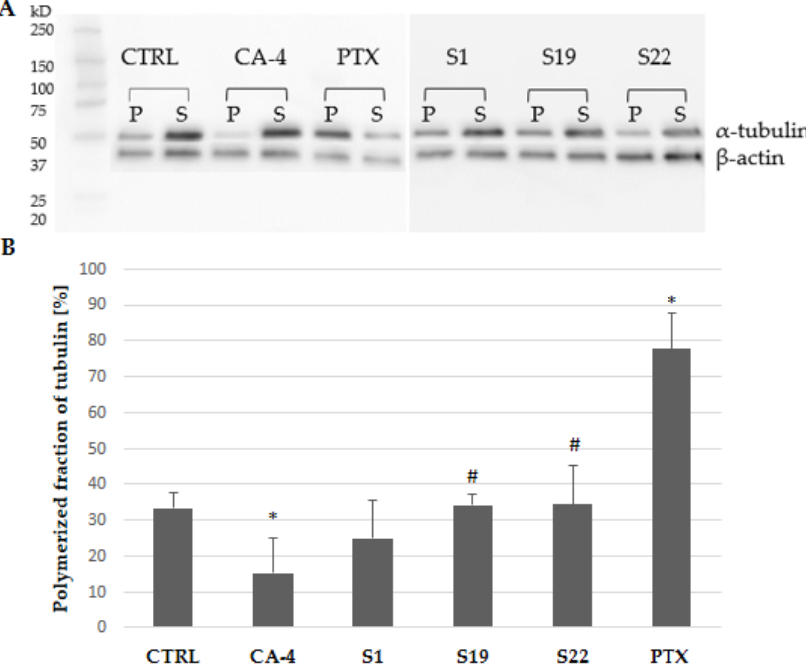
Figure 8. ( A ) Western blot analysis of polymerized microtubules (P) and soluble tubulin dimers (S) fraction in the cells after 6 h treatment with indicated compounds. Original images for blots in Supplementary Materials (Figure S6). ( B ) Per- centage of α-tubulin in the pellet fraction after densitometric analysis of western blot gel. Each densitometric value of tubulin was normalized to the densitometric value of β-actin. Data are expressed as the mean and SD from four independ- ent experiments; * p < 0.05 vs. ctrl; # * p < 0.05 vs. CA-4).